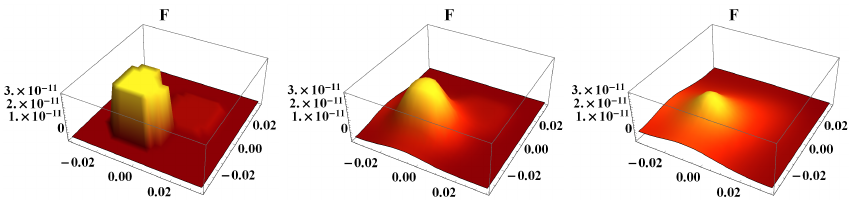
Figure 5. Distributions of Fe concentration c 3 for the times 0, 7 and 28 days respectively.